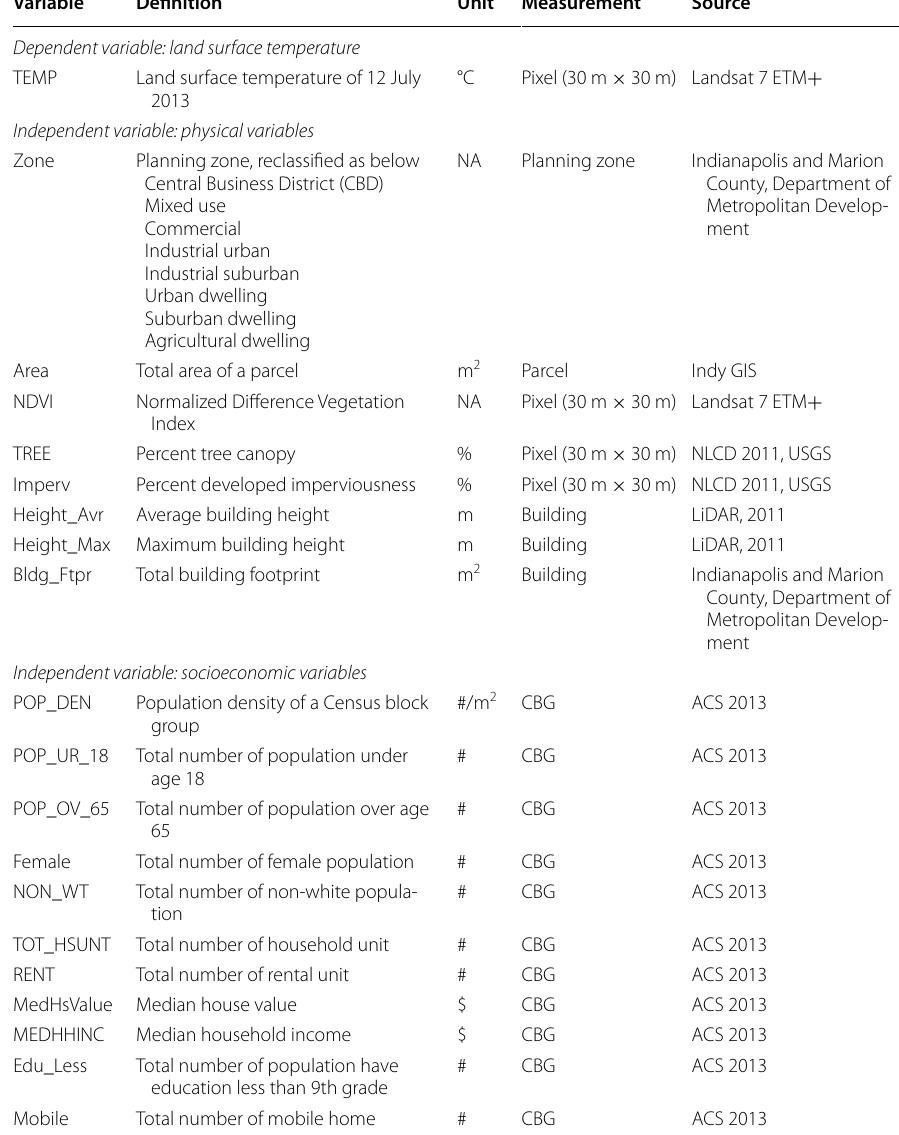
Table 1 Summary of physical and socioeconomic variables Variable Definition Unit Measurement